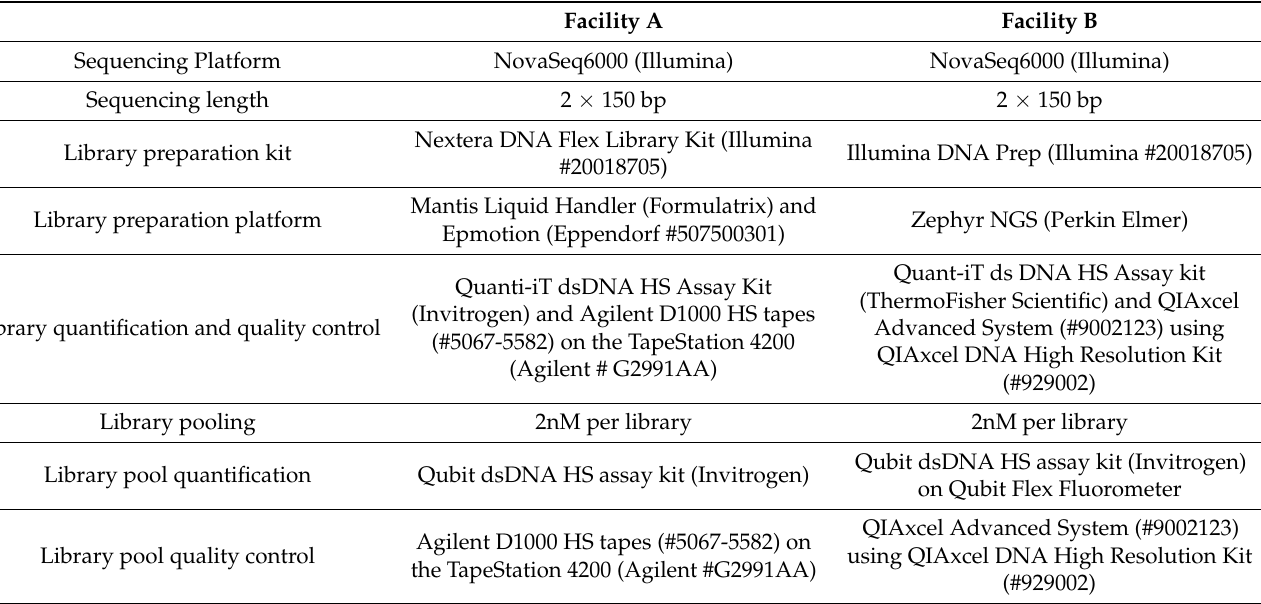
Table 2. Comparison of library preparation and sequencing